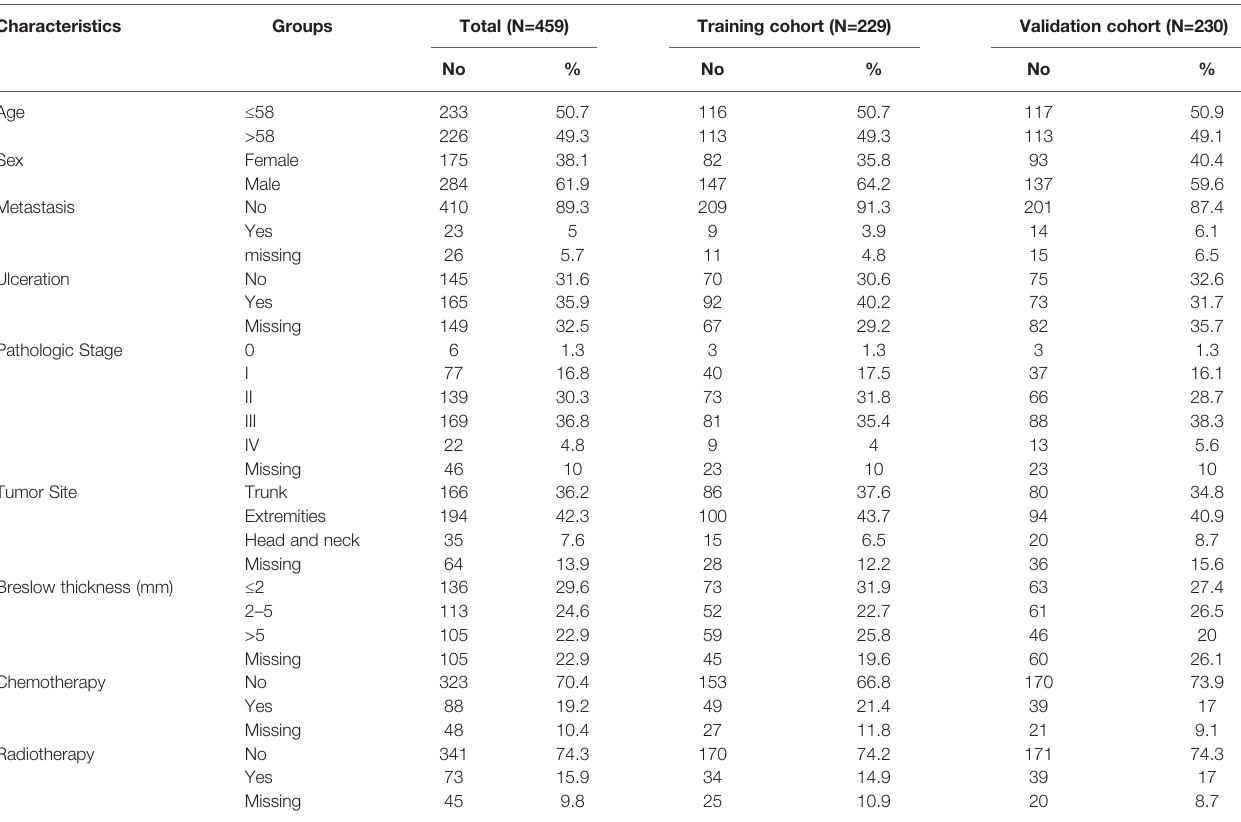
TABLE 1 | Basic characteristics of TCGA CM patients. Characteristics